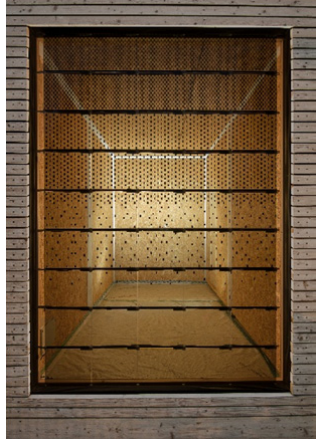
Fig. 3 Prototype of the structured switchable glazing in a façade test facility.TN-cells partially darkened. Phot.: J. Rettig,